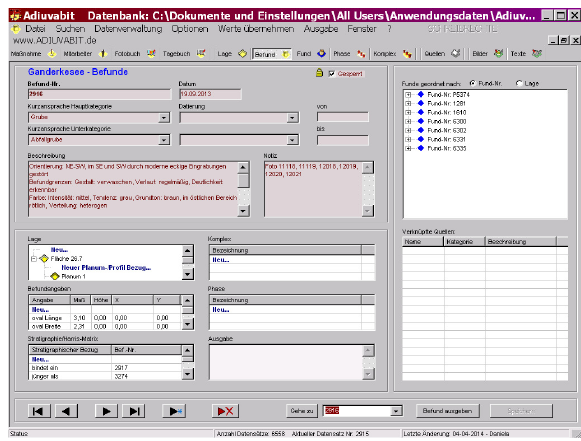
Figure 12: Generated record for a finding in Adiuvabit database.